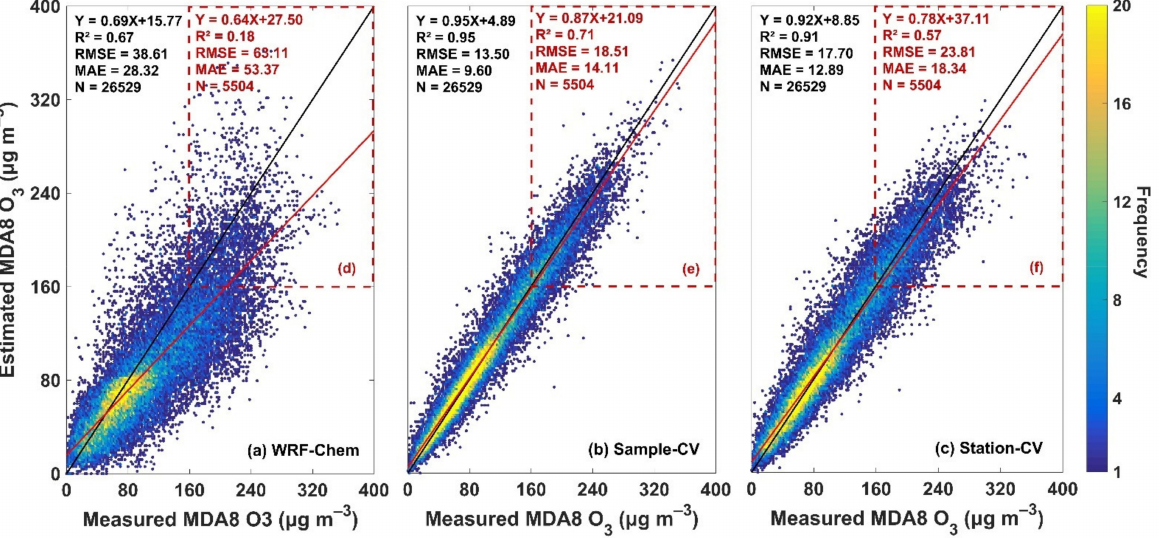
Figure 3. Frequency density scatter plots between the estimated and measured MDA8 O 3 . ( a ) WRF- Chem model fitting. ( b , c ) WRFC-XGB model sample-based and station-based 10-CV results, re- spectively. ( d – f ) Simulation results for MDA8 O 3 greater than 160 µ g m − 3 . The black and red lines represent the 1:1 line and regression line,